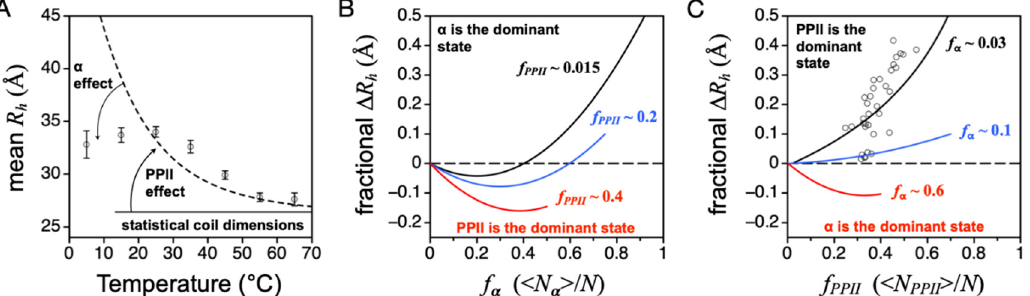
Figure 8. Temperature, α , and PPII effects on DSE hydrodynamic size. ( A ) Open circles show Retro-nuclease mean R h measured using DLS methods from 5 to 65 °C. The dashed line was calculated with Equation (2) and modeling temperature effects on the intrinsic PPII propensities by Equation (3) and with ∆ H PPII = 13 kcal mol − 1 . Temperature-dependent changes to the amino acid PPII propensities, from Equation (3), cause the Equation (2)-predicted R h to change accordingly. ( B , C ) Simulated effects on population-weighted size from α and PPII bias. Fractional change in mean R h (i.e., < L >/2) was used to normalize simulation results for chain length. In panel C, open circles represent experimental R h measured for IDPs and normalized relative to the simulated size of an unbiased ensemble [37], as explained in the main text. f PPII for each IDP was calculated from sequence using the IDP experimental PPII scale (blue bars, Figure 6C).